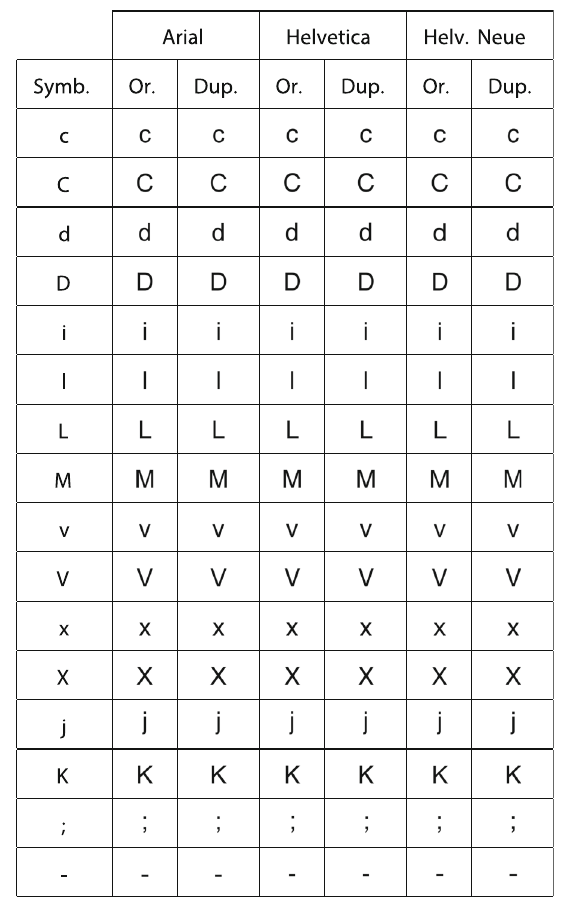
symbols) but only its appearance; thus, the watermark is retained with any change of font. In fact, the water- marked text—being a string of Unicode symbols—is not bound to a particular font and has no font embedded in it. If a malicious user copies the watermarked text in a word editor and changes the font to any other font, the watermark is still retained. On the other hand, if a